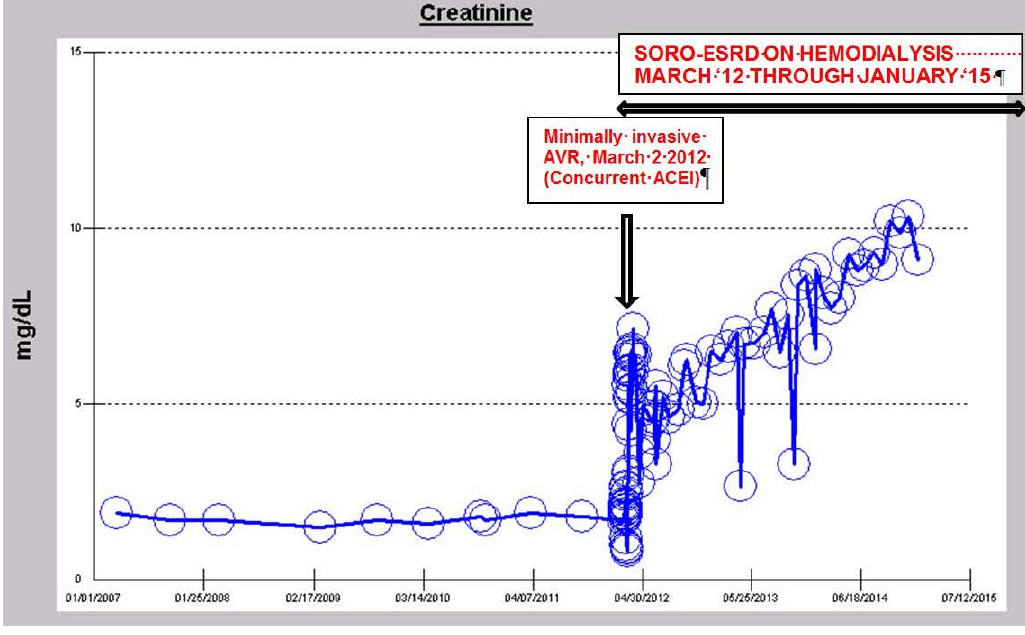
Figure 7. Serum creatinine trajectory, 2007–2014, with AKI in March 2012 in a 73-year-old morbidly obese, diabetic, hypertensive, CKD III Caucasian male following minimally invasive AVR for symptomatic aortic